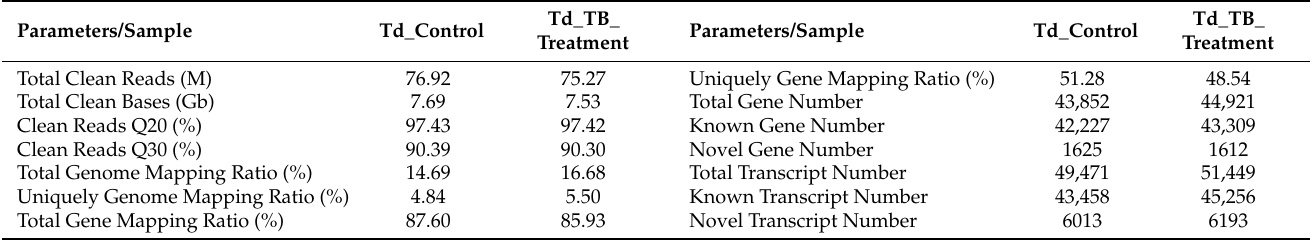
Table 3. Quality estimation results of sequencing data of shoots of T. dicoccum (Td) grown in high-B (10 mM B) conditions as compared to control (3.1 µ M B), and the statistics of reference genome alignment.